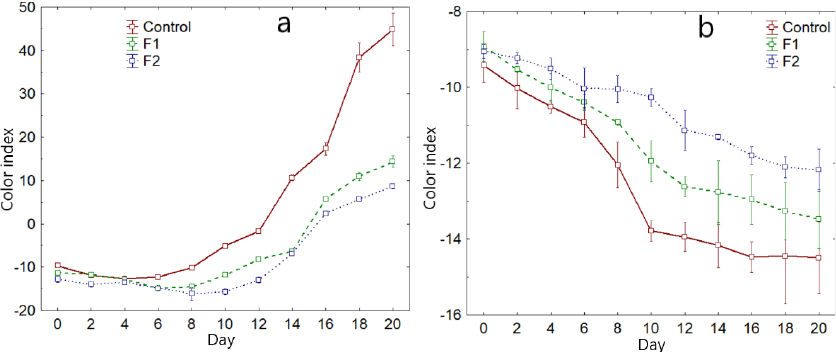
Figure 7. Color index variation, ( a ) Hass variety, ( b ) Fuerte variety.